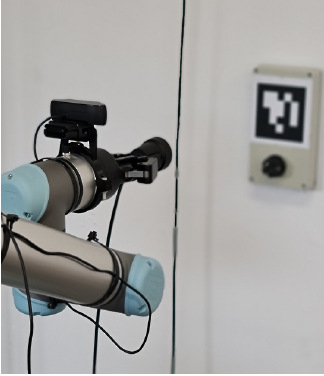
Figure 8. Center gripper taking the fiducial marker as a visual reference.